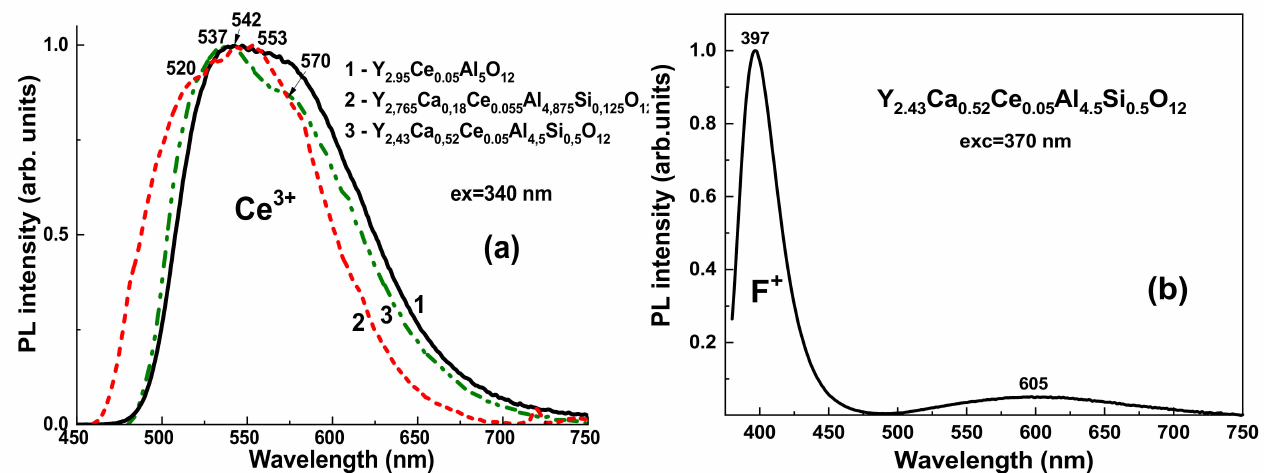
Figure 6. ( a )—RT PL spectra of Y 3 − x Ca x Al 5 − y Si y O 12 :Ce SCF with different Ca and Si content x/y = 0.18/0.125 (2) and y = 0.52/0.5 (3) in comparison with PL spectra of YAG:Ce SCF (1) under excitation in the vicinity of Ce 3+ absorption band at 340 nm. ( b )—RT PL spectra of F + center in Y 2.43 Ca 0.52 Ce 0.05 Al 4.5 Si 0.5 O 12 SCF under excitation at 370 nm in the respective absorption band of this center.